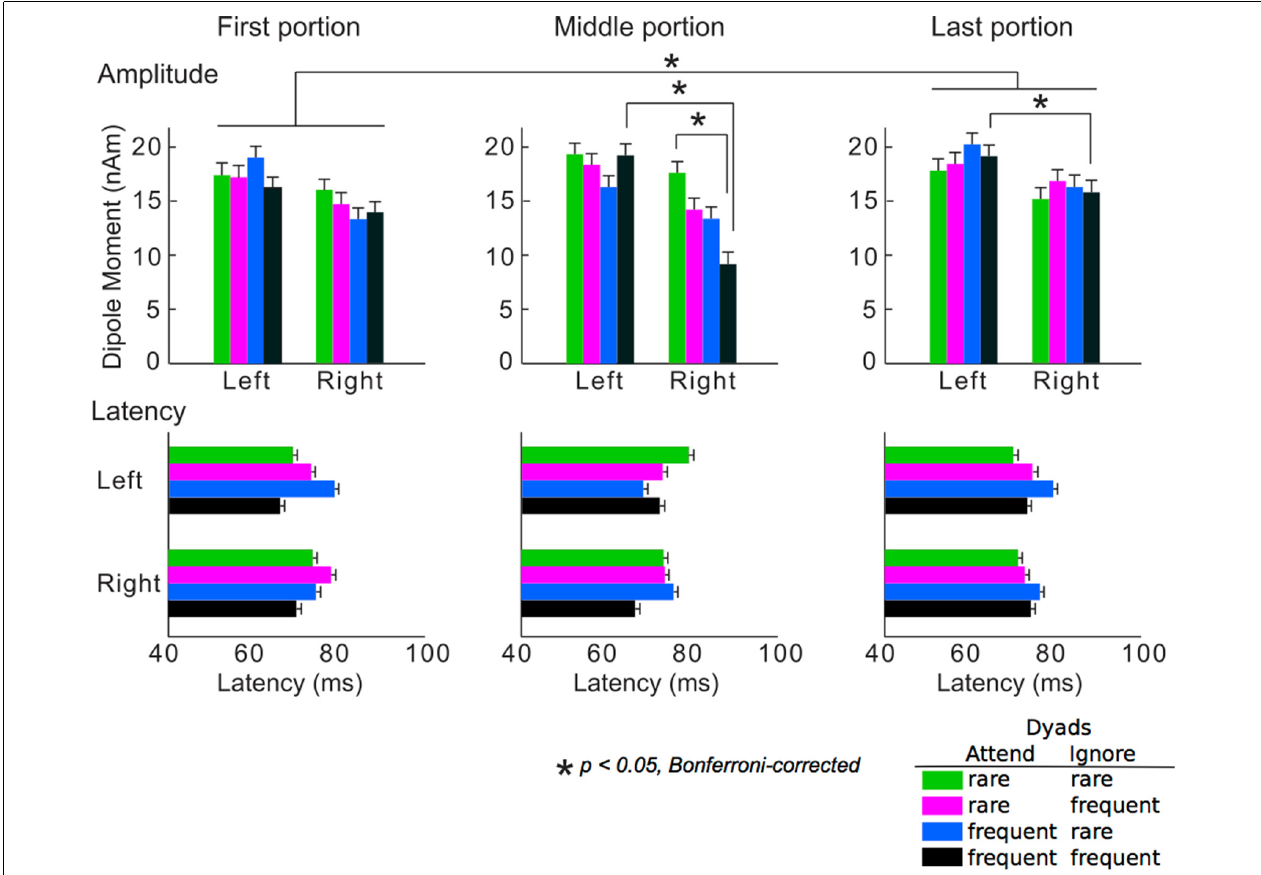
FIGURE 4 | Mean peak amplitudes (upper) and the latencies (lower) of P1m. Green bars: responses to chords consisting of two rare tones in attended and ignored sequences; pink bars: responses to chords consisting of a rare tone in attended sequence and a frequent tone in ignored sequence; blue bars: responses to chords consisting of a frequent tone in attended sequence and a rare tone in ignored sequence; black bars: responses to chords consisting of two frequent tones in attended and ignored sequences. Asterisks indicate significant differences ( p < 0.05,